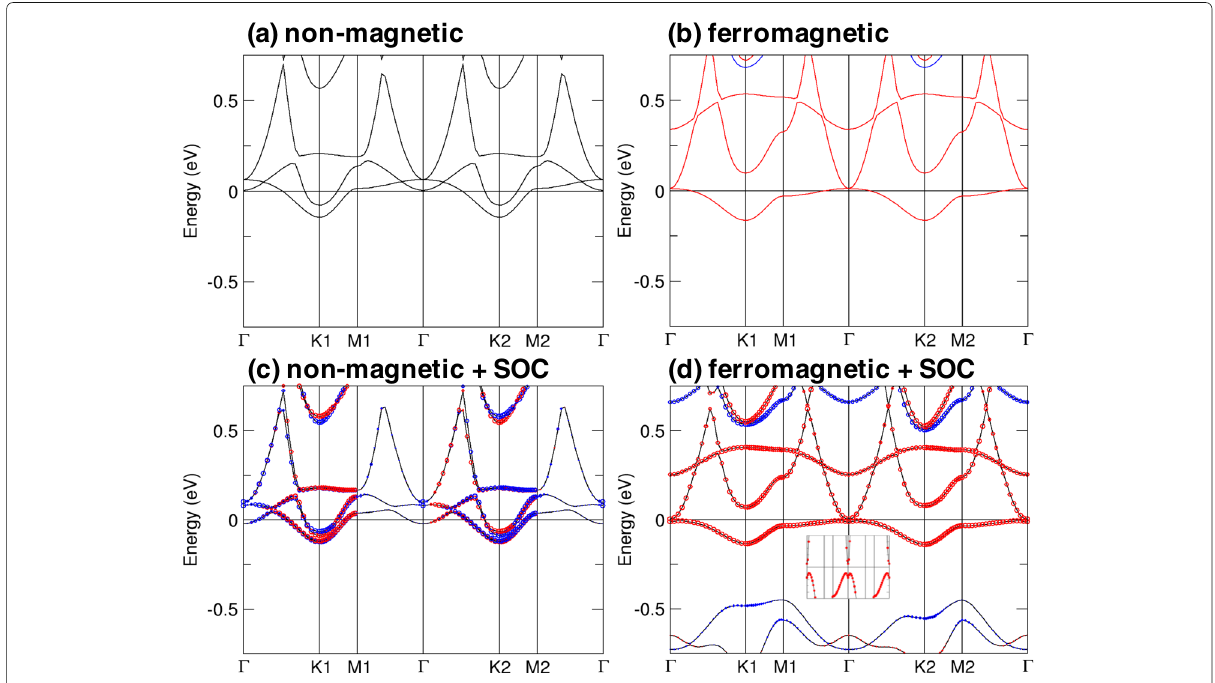
Fig. 6 Electronic band structures of planar TiBi film at a = 4.76 Å for non-magnetic calculations ( a ) without SOC and ( c ) with SOC as well as ferromagnetic calculations ( b ) without SOC and ( d ) with SOC. Red and blue circles indicate + s z and − s z contributions, respectively, for ( c ) non-magnetic ( d ferromagnetic) calculations with SOC